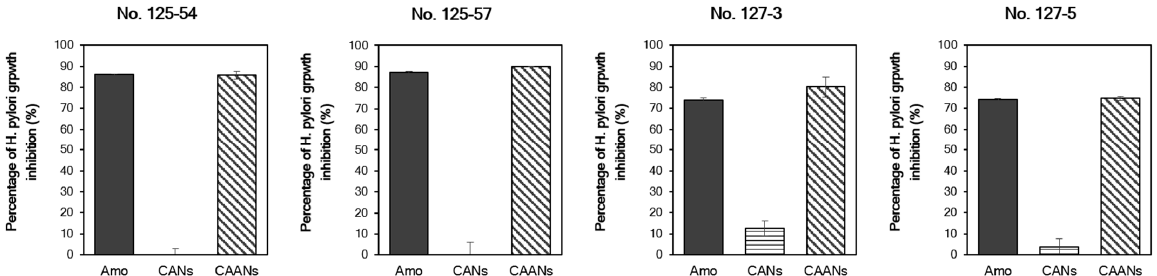
Figure 4. Percentage of H. pylori growth inhibition of the free amoxicillin, CAN, and CAAN treatments. The minimum inhibitory concentration (MIC) values of H. pylori strains No. 125-54, 125-57, 127-3, and 127-5 are ≥ 0.5, 0.25, 0.0625, and 0.0625 μ g/mL, respectively. The treated concentration of amoxicillin was on the basis of the MIC value of each H. pylori strain.